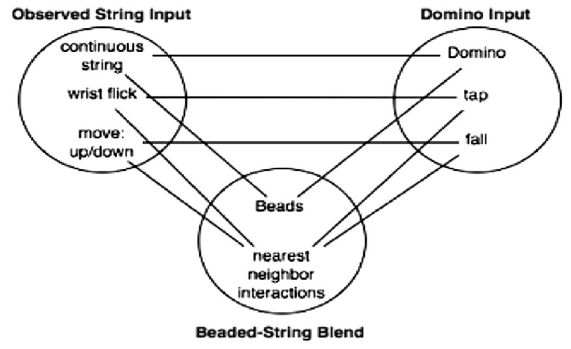
FIG. 2. Beaded-string blend from Wittmann